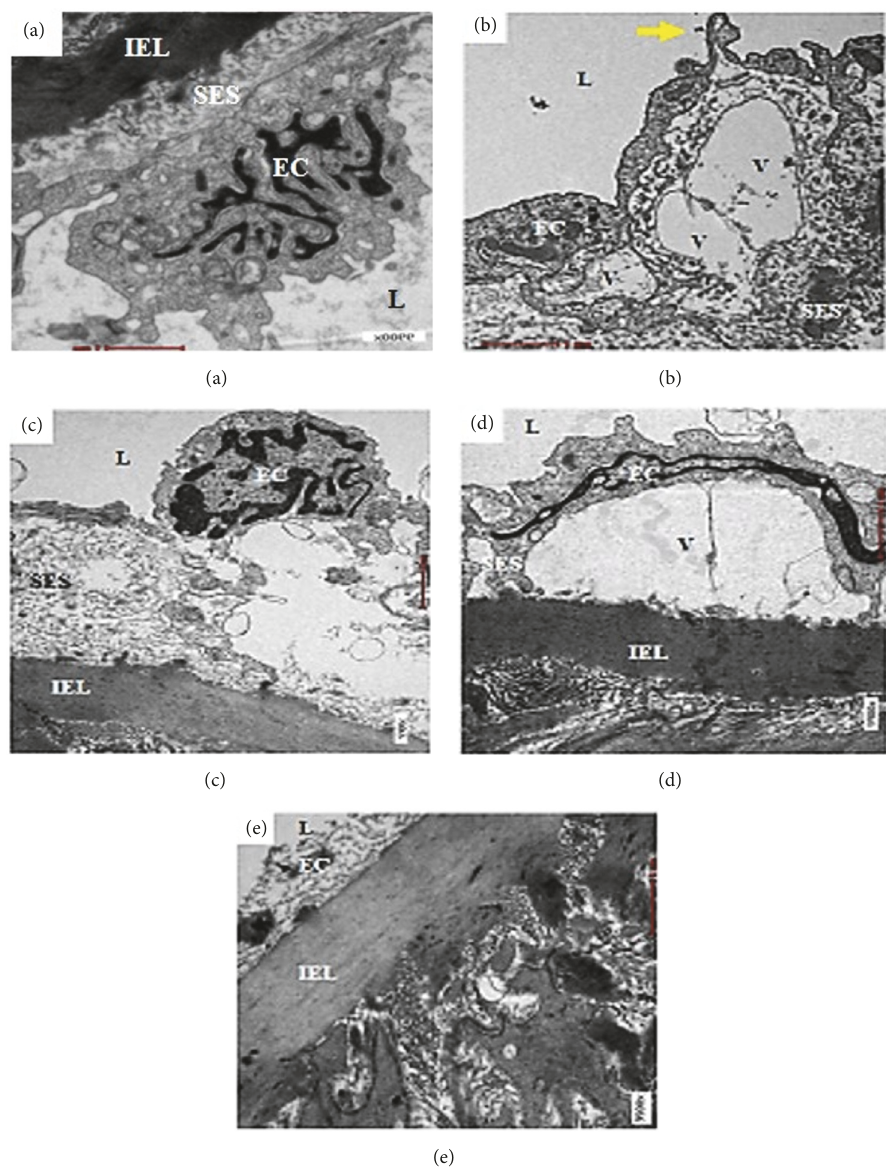
Figure 2: Electron micrograph showing endothelium of the thoracic aorta of (a) Sham, (b) OVX, (c) OVX+ST, (d) OVX+MCLD, and (e) OVX+MCHD. Vacuolation (V) of the endothelium with hook-like cytoplasmic process (arrow) and widened subendothelial space (SES) filled with granular substances were noted in (b) OVX. L: lumen, EC: endothelial cell, IEL: internal elastic lamina. EM X9900.